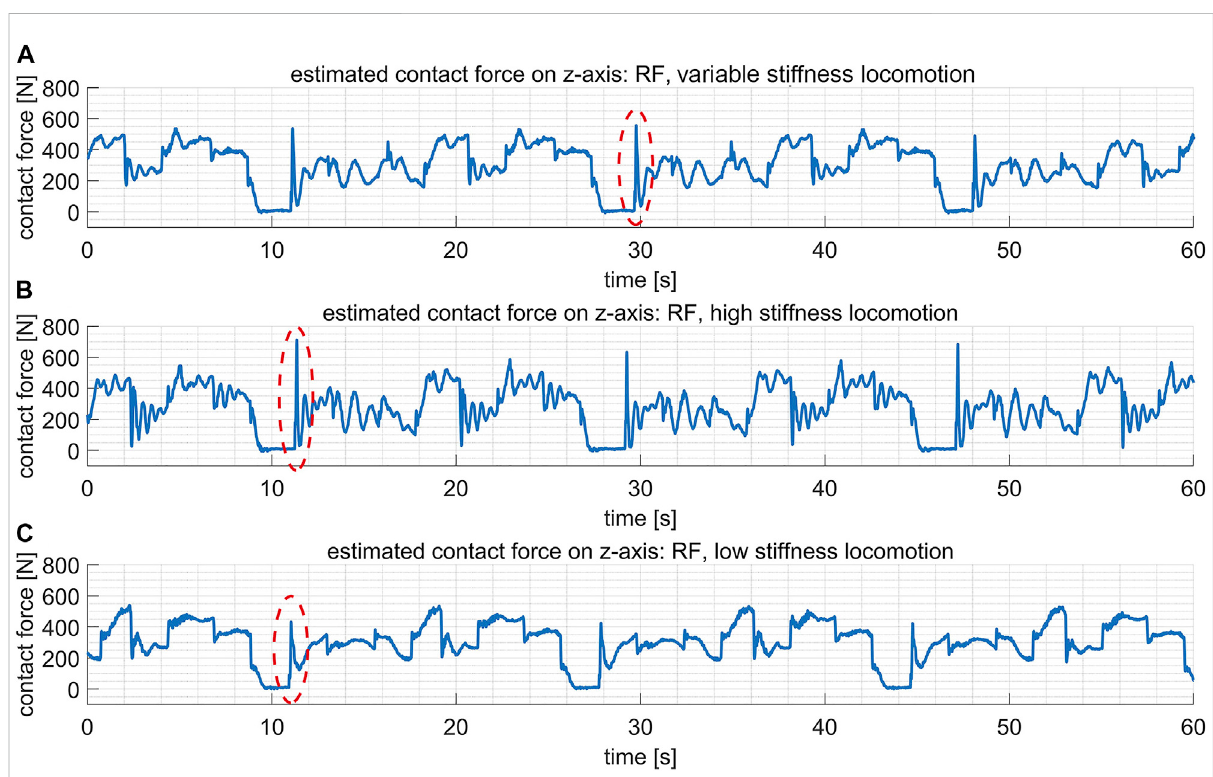
FIGURE 11 Theestimatedcontactforce(on z -axisoftheworldframe)ofthelegRFinthreecomparativetests.Themaximumcontactforcesatthemoment of contact are marked by the red ellipses. (A) In the variable stiffness locomotion. (B) In the high stiffness locomotion. (C) In the low stiffness